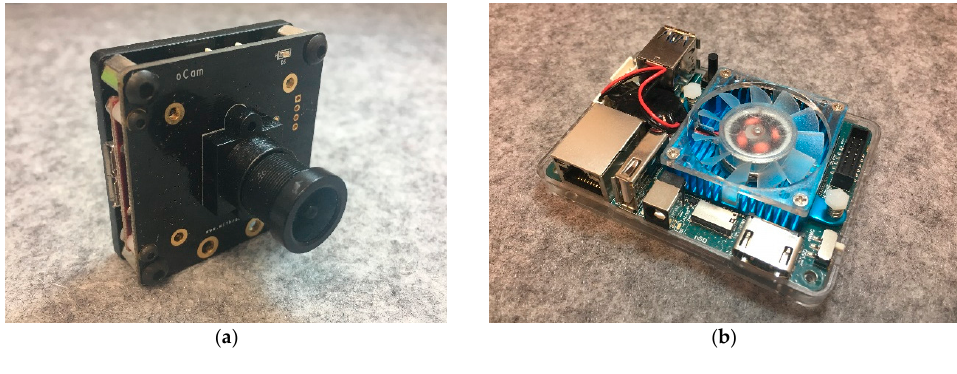
Figure 5. ( a ) oCam [25] and ( b ) Odroid XU4.